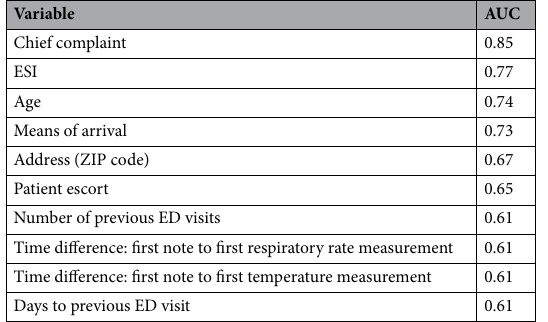
Table 3. Tabular variables with the 10 highest AUC contributions for admission to the NSICU. NSICU neuroscience intensive care unit, AUC area under receiver-operating-characteristic curve, ESI Emergency Severity Index, ZIP zone improvement plan, ED emergency